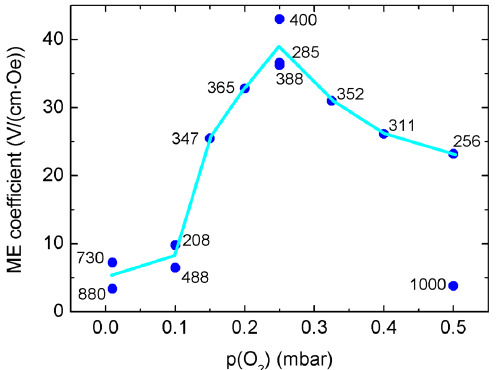
Figure 8. Magnetoelectric voltage coefficients α ME of BaTO 3 ‐ BiFeO 3 composite thin films on SrTiO 3 :Nb(001) measured at 300 K and at the DC bias magnetic field with the maximum α ME . The number at each data point is the composite film thickness as determined from STEM images of cross ‐ sections prepared by focused ion beam (see the Supplementary Materials, Figures S14 and S15). The line is drawn to guide the eye only. Using the film thicknesses, structural details of the samples (Table 1) can be assigned to the α ME values.